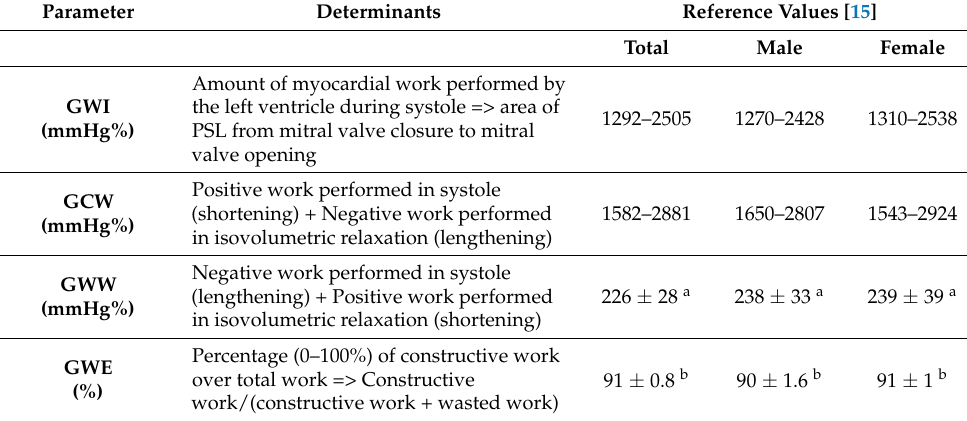
Table 1. Determinants of myocardial work indices and reference values according to gender. Parameter